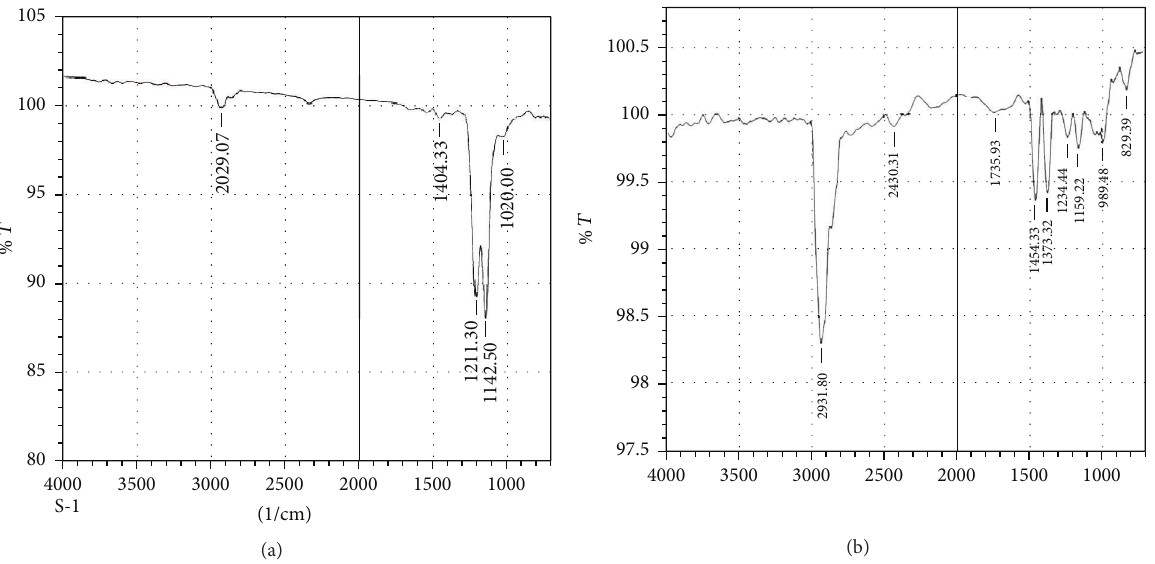
Figure 9: (a) FTIR spectrum of PP and (b) FTIR spectrum of 15% raw BBF/PP composite.